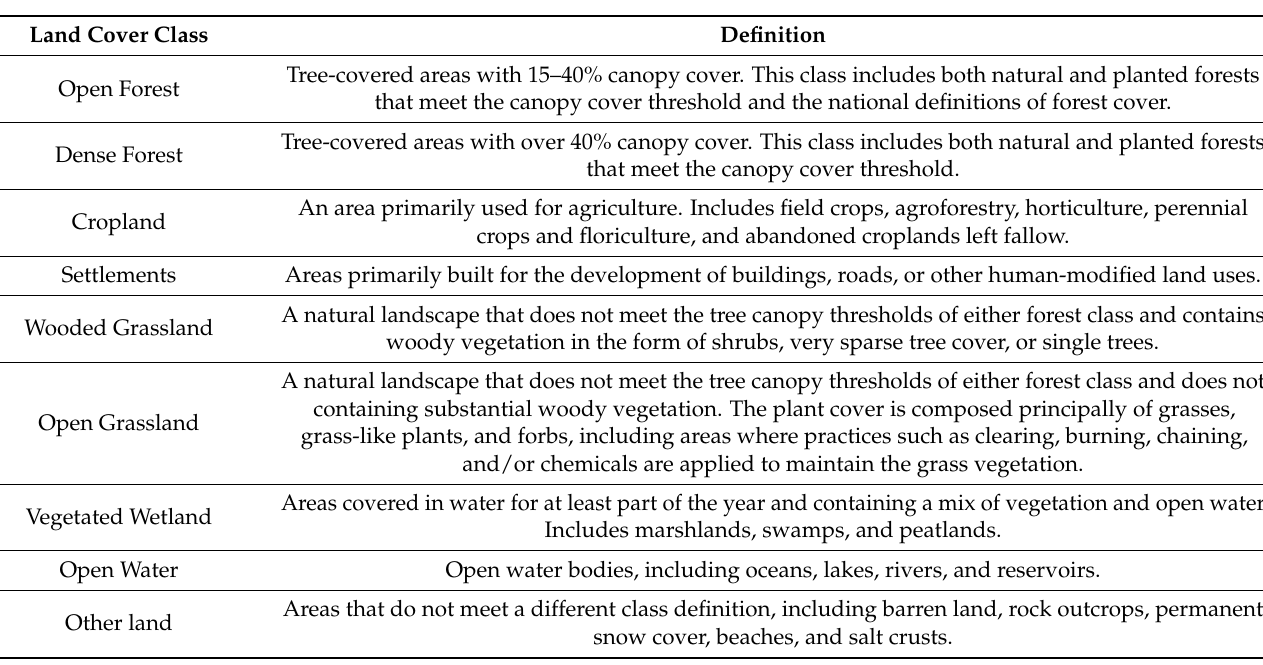
Table 1. Land cover class definitions are derived as sub-classes from the International Panel on Climate Change (IPCC) top-level land use